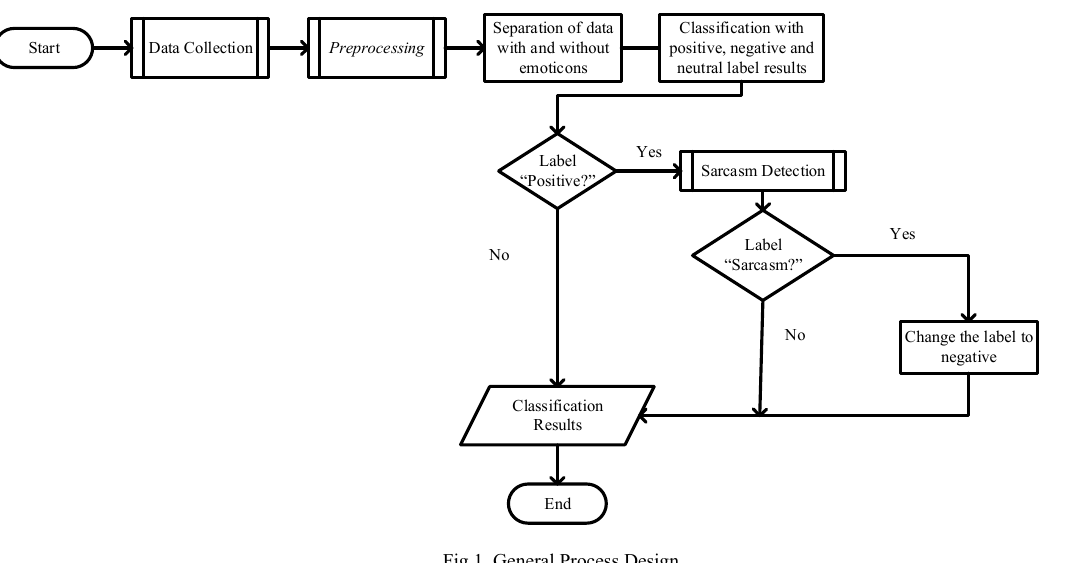
Fig.1. General Process